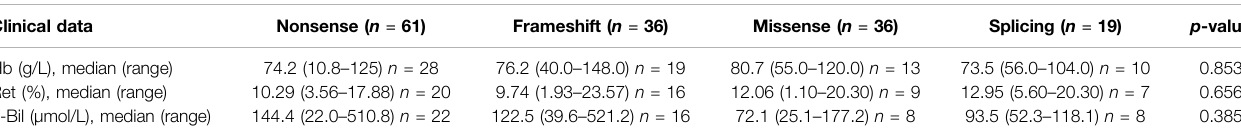
TABLE 4 | Comparison of clinical features of HS patients with different types of mutation. Clinical